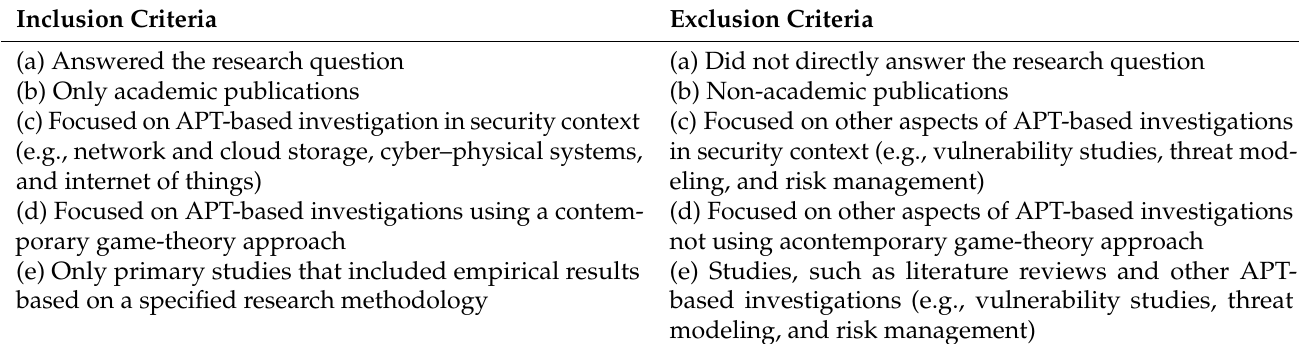
Table 4. Inclusion and exclusion criteria for the relevant literature search (article